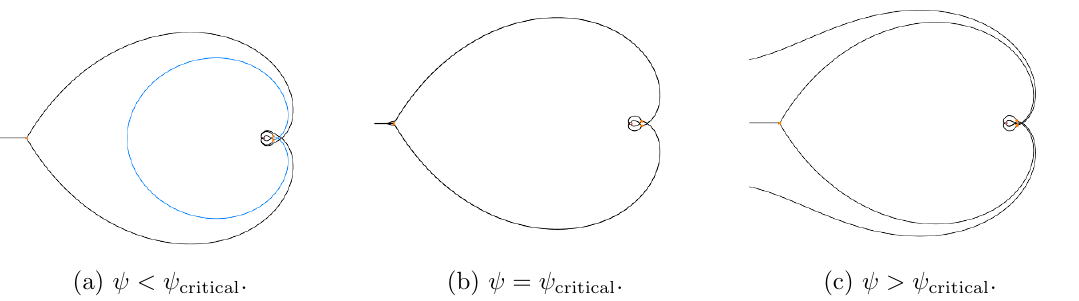
Figure 46. Decay of the large volume D2-brane along the negative -axis.